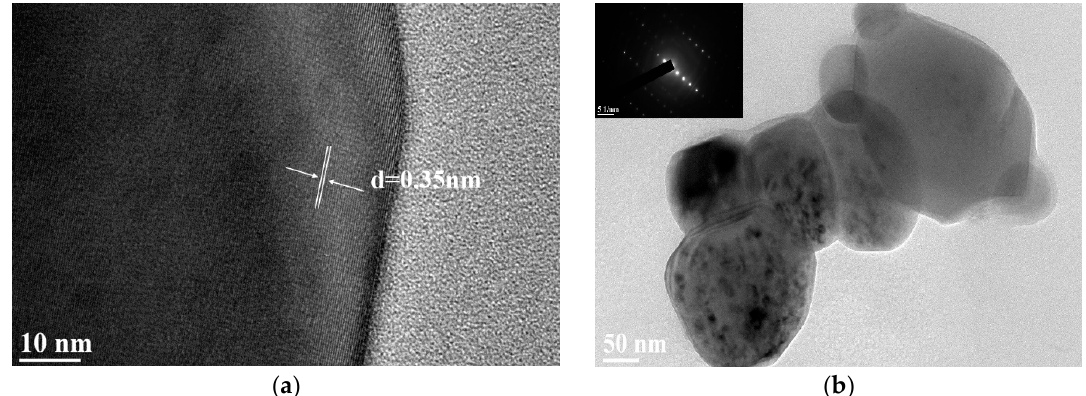
Figure 6. The HR-TEM ( a ) and TEM ( b ) images of Fe/N/Co–TiO 2 particles.